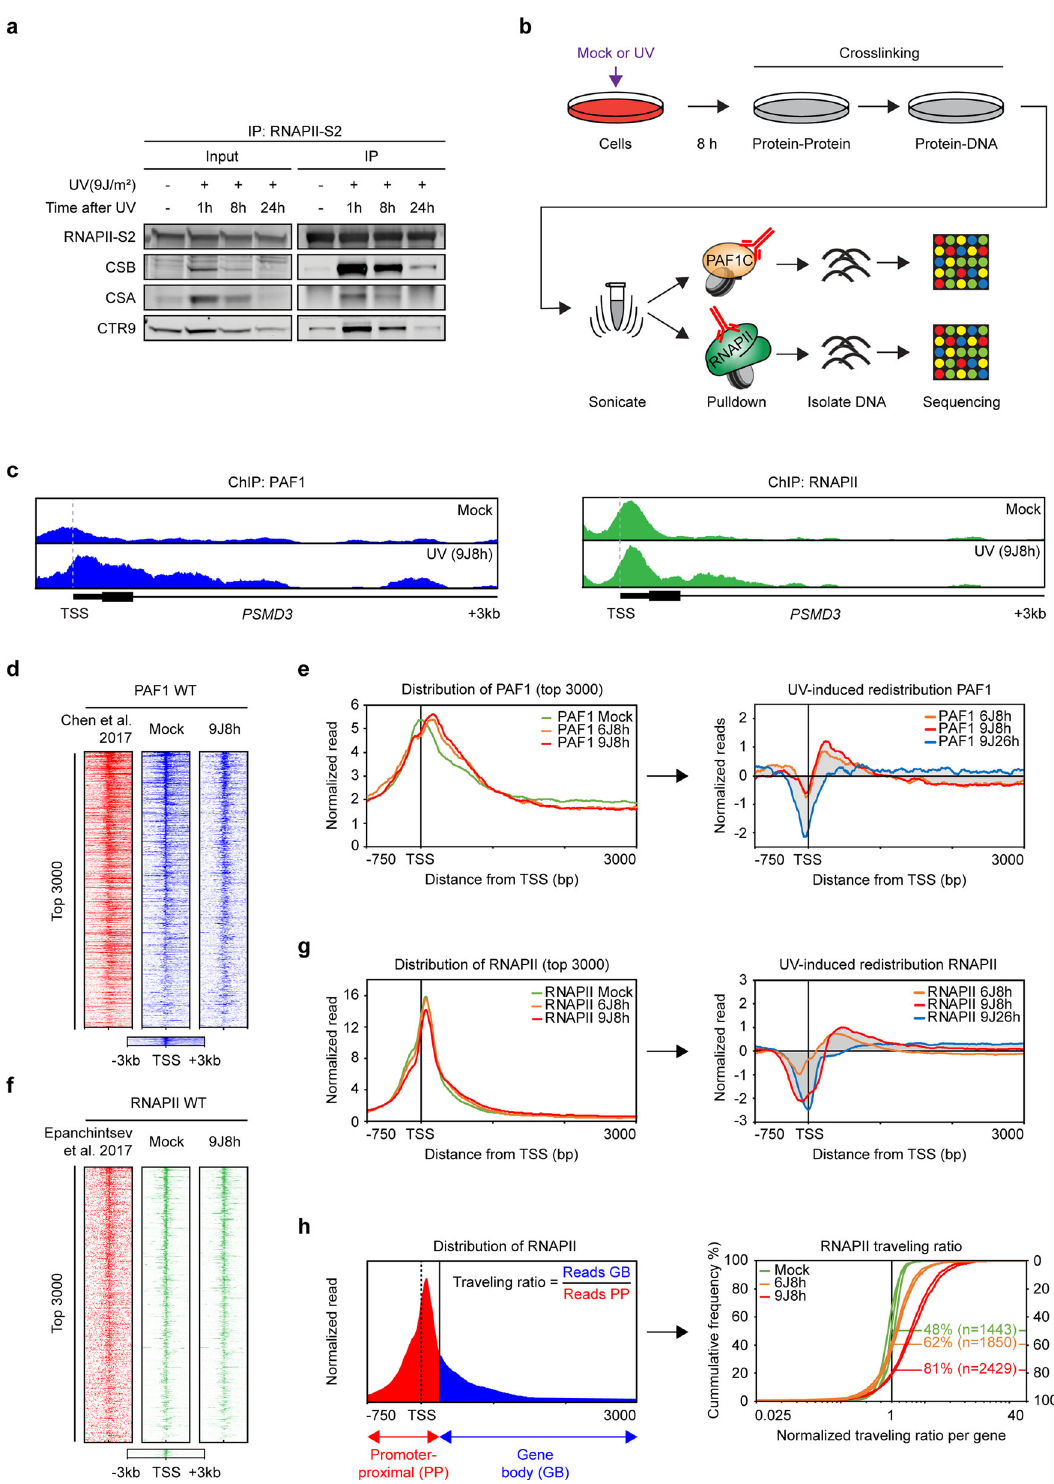
observed (Fig. 5e). The shift in RNAPII binding was no longer detected at 26 hrs after UV irradiation (Fig. 5g, Supplementary Fig. 5b), coinciding with the loss of PAF1C binding to RNAPII (Fig. 5a), and near complete transcription recovery (Fig. 4e, h). Representative examples of short ( ARF6 , 5 kb), intermediate ( NDUFS5 , 10 kb) and longer genes ( PSMD3 , 24 kb) all show the UV-induced redistribution of both PAF1 and RNAPII within the fi rst 2 kb of the gene (Supplementary Fig.